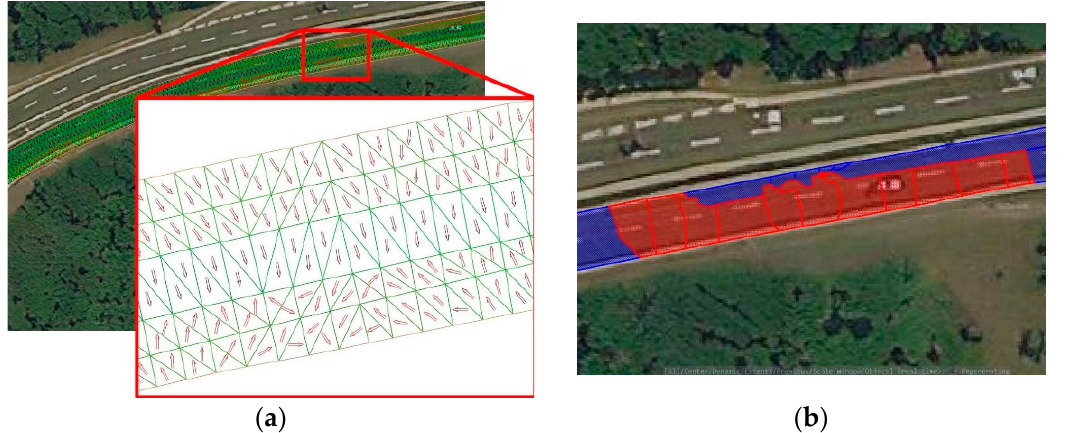
Figure 12. Analysis results on the digital surfaces generated by the model: ( a ) slope patterns in a certain area of a layer of the pavement; ( b ) drainage basins on a layer of the pavement with an indication of those that form a depression on the surface.